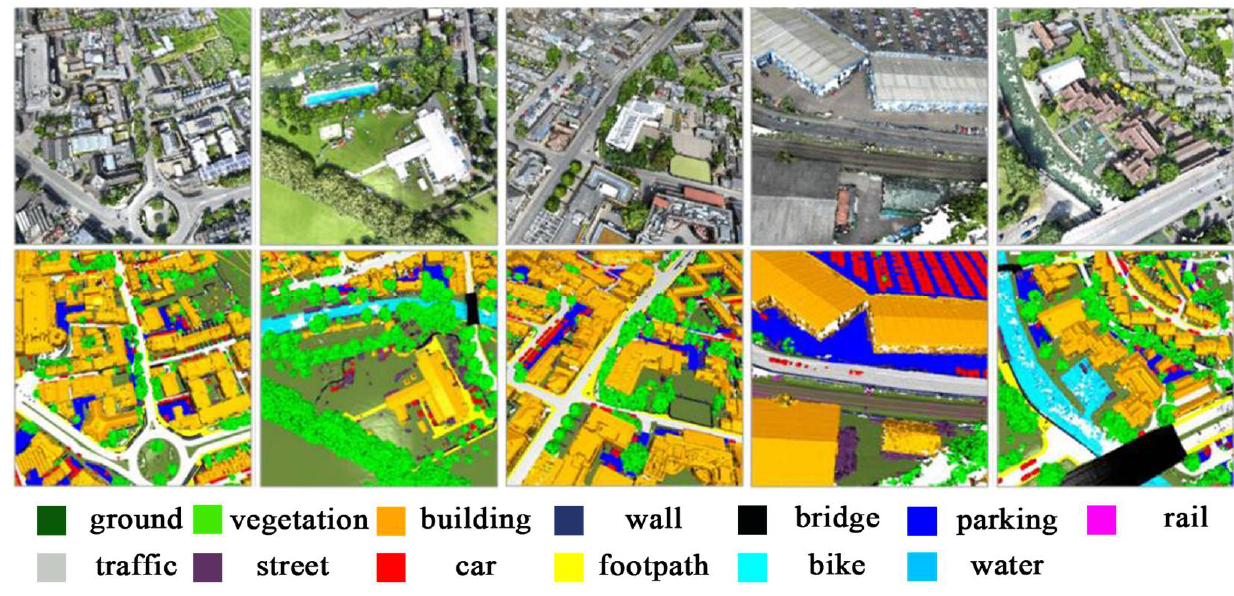
Figure 4. SensatUrban Dataset.